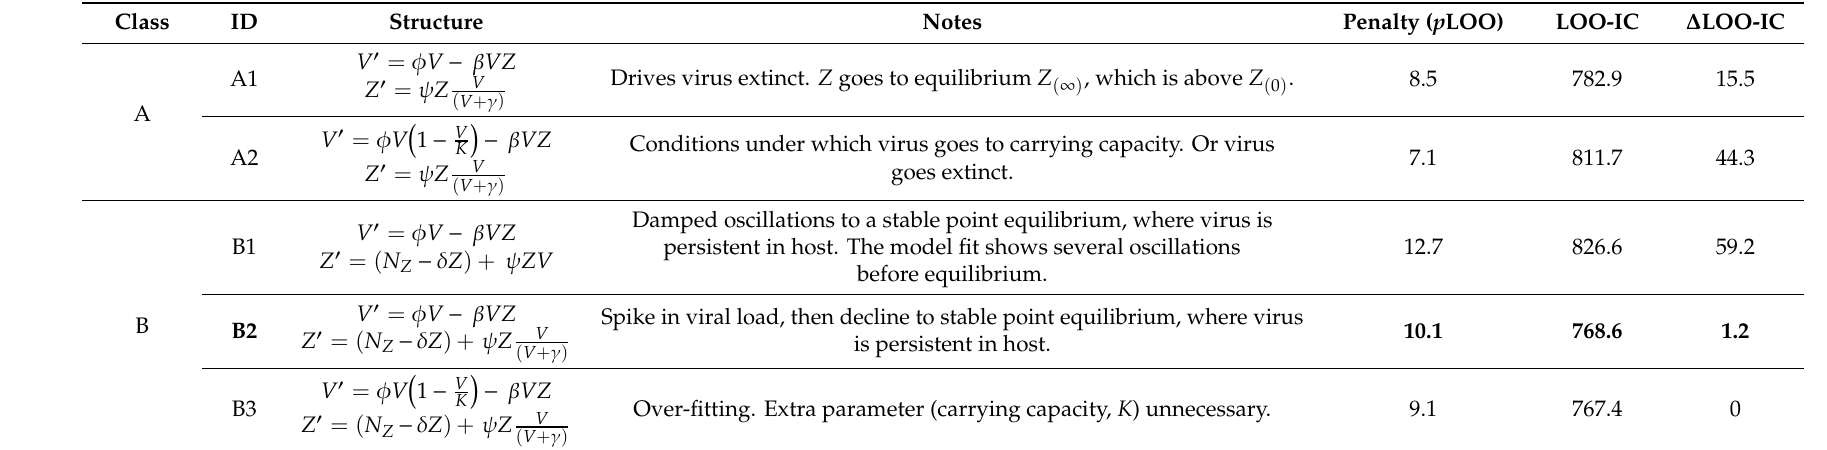
Table 1. Model structures and model comparisons. The bolded model (B2) is the most parsimonious based on LOO-IC selection and the lower number of parameters compared to